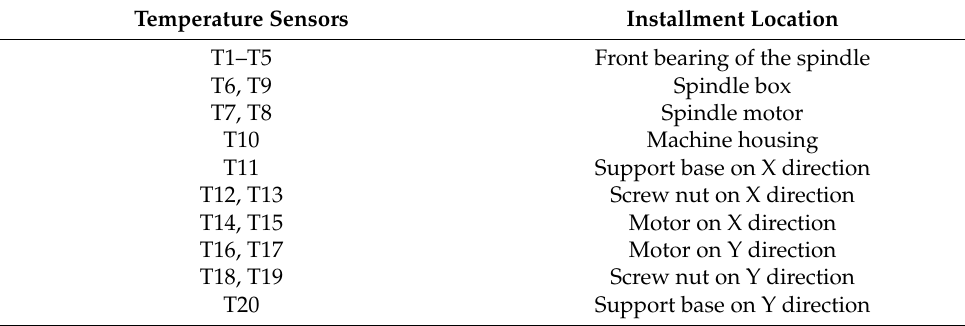
Table 1. Detailed installment location of sensors.